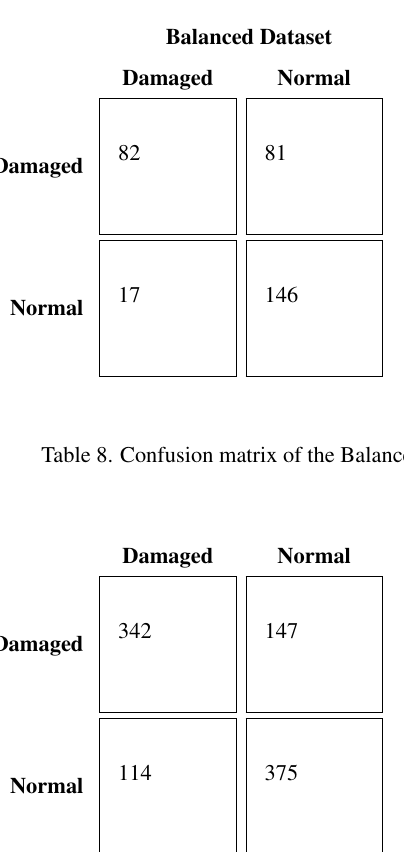
Table 7. Confusion matrix of the Unbalanced Dataset.